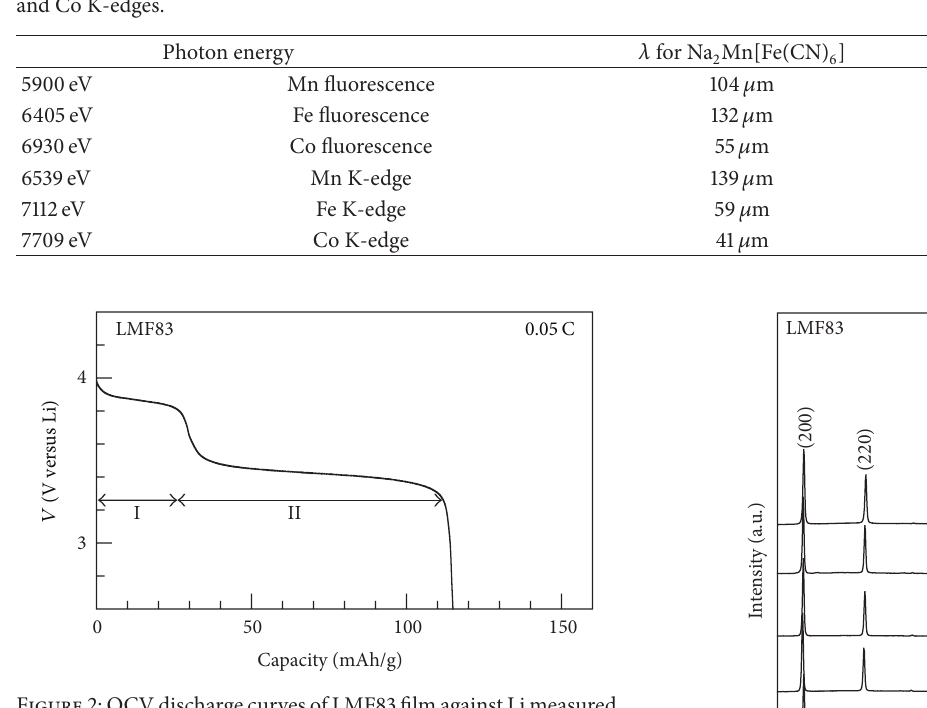
Mn[Fe(CN) ] and Na Co[Fe(CN) ] at the fluorescence and absorption energies of the Mn, Fe, 2 6 2 6